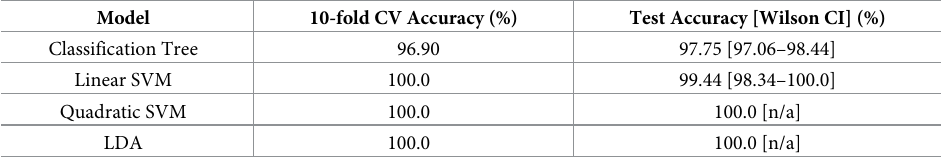
Table 4. Accuracy of source location prediction by classification.